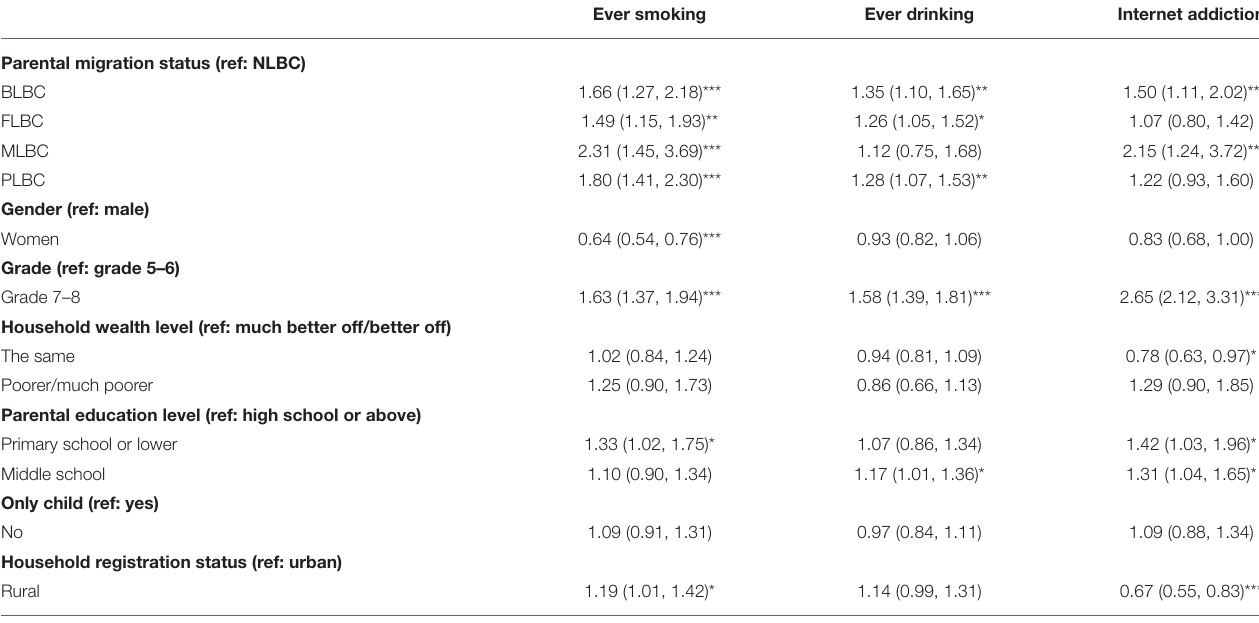
TABLE 5 | Logistic regression analysis for risk behaviors by parental migration groups and demographic characteristics, OR (95% CI). Ever smoking Ever drinking Internet